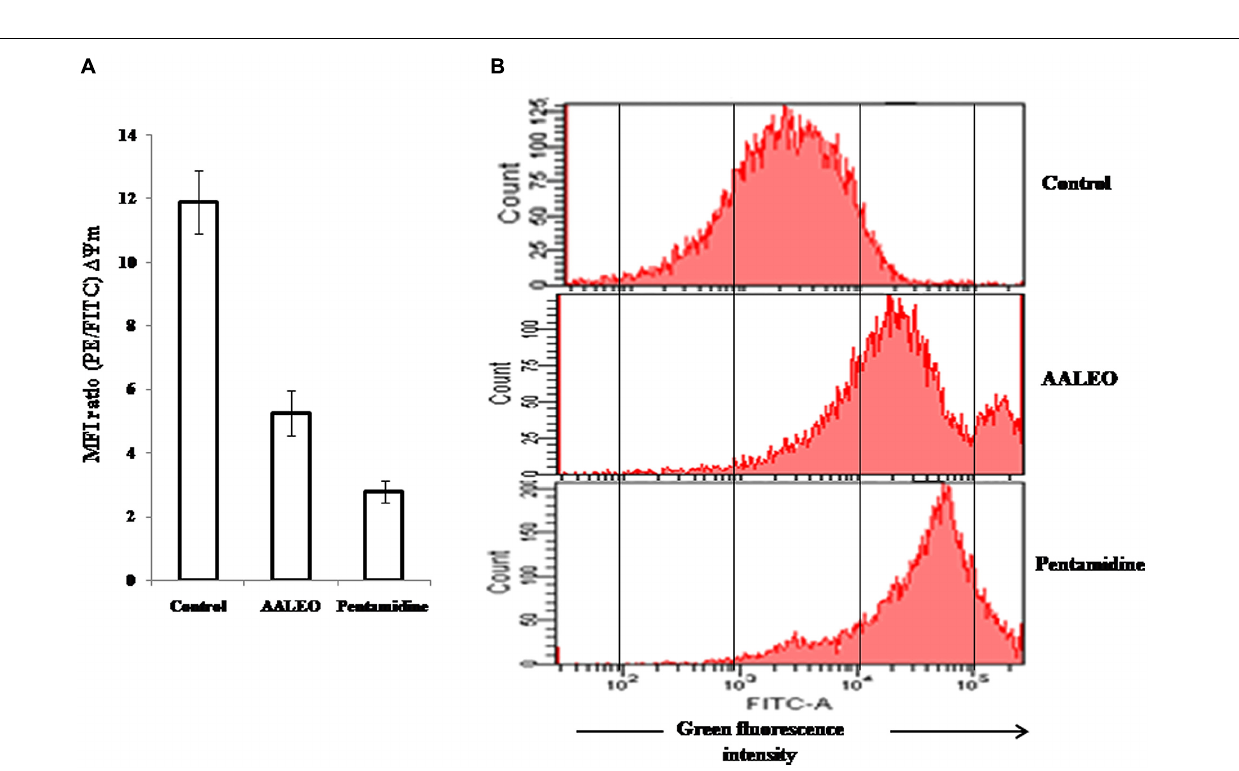
statistics. (B) Histograms depict shift in green fluorescence intensity (FL-1) from left, depicting increased production of ROS in treated promastigotes loaded with H 2 DCFDA. Each bar corresponds to the mean ± SE of triplicate samples and histograms are representative profiles of three independent